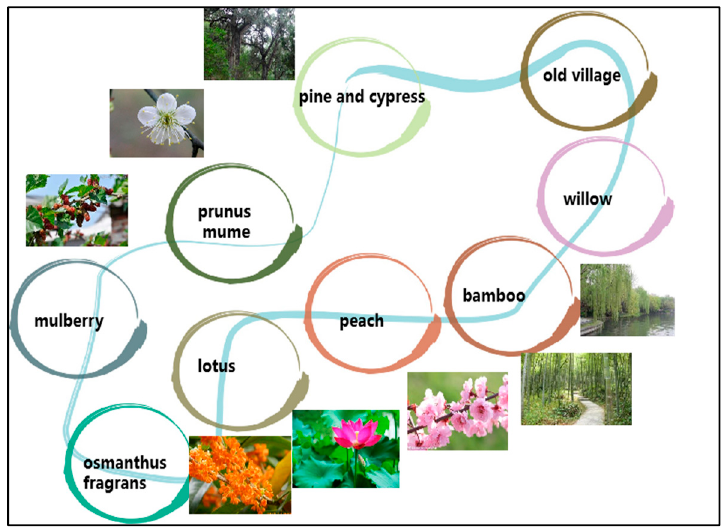
Figure 3. Design of eight scenes with typical plants in Heshu village.